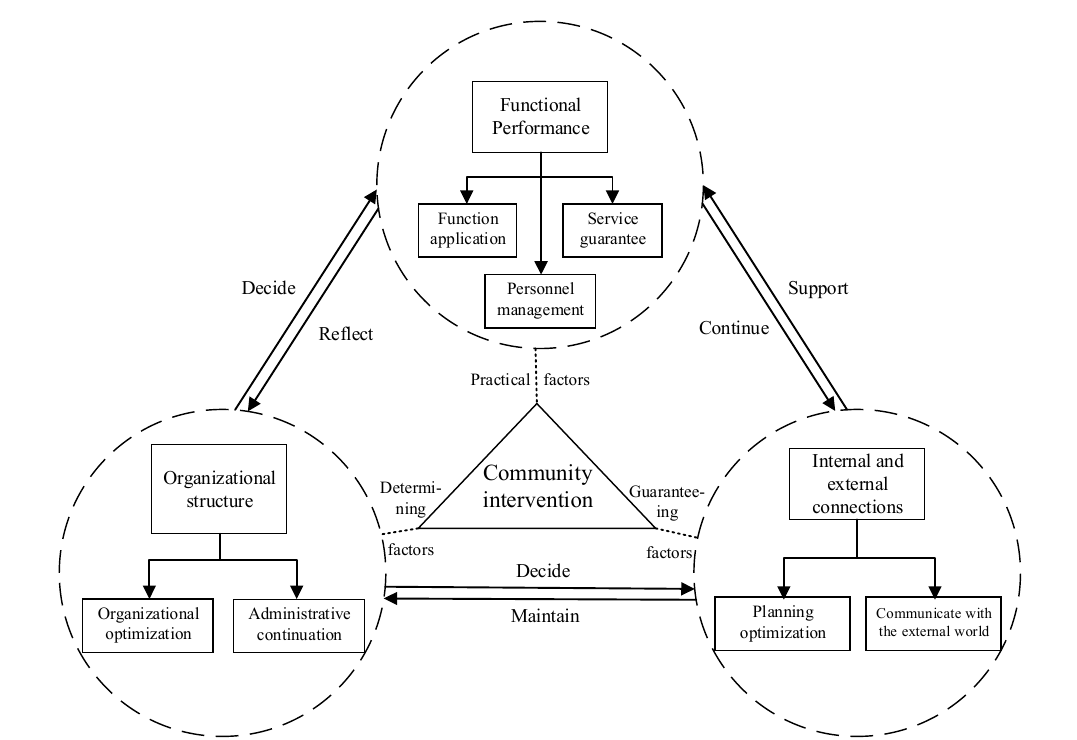
Figure 2. System of community intervention in major public health events (MPHEs).